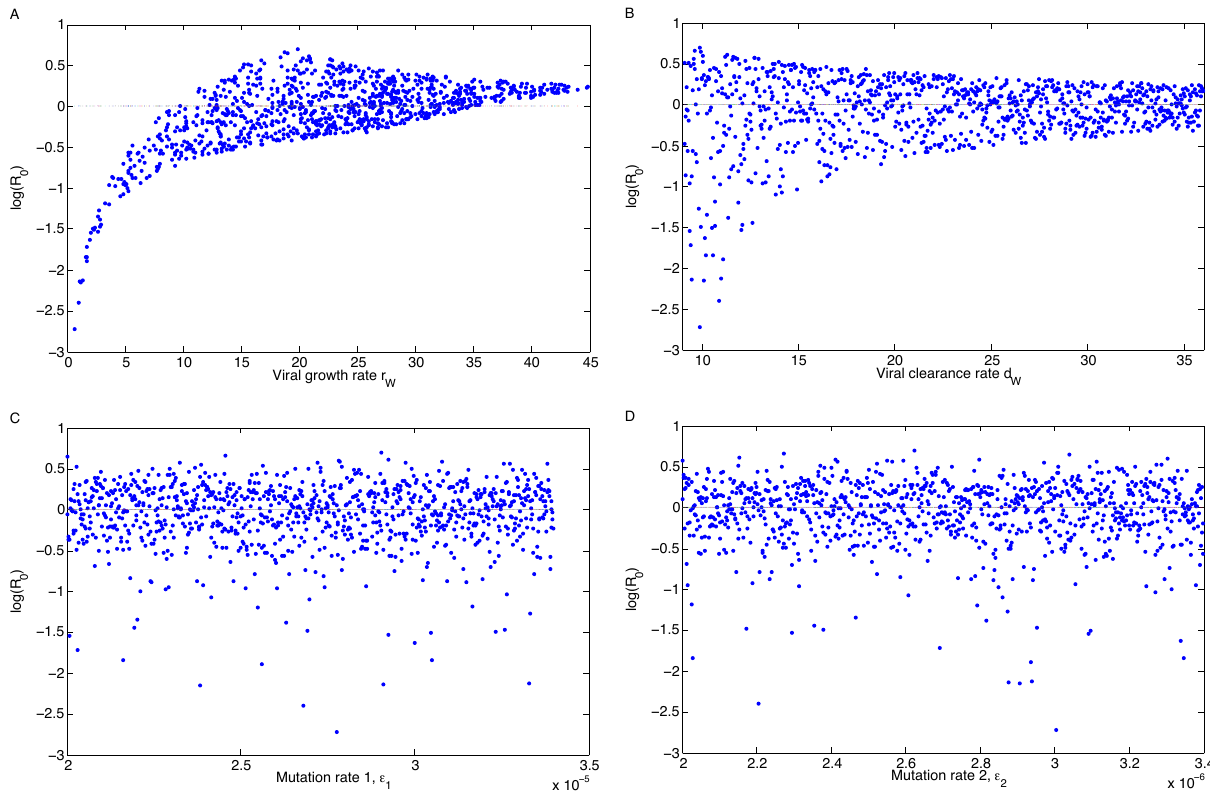
Figure 8. Landscape plots of R viral growth rate can be reduced below 10 , then eradication is likely, regardless of variations in the other